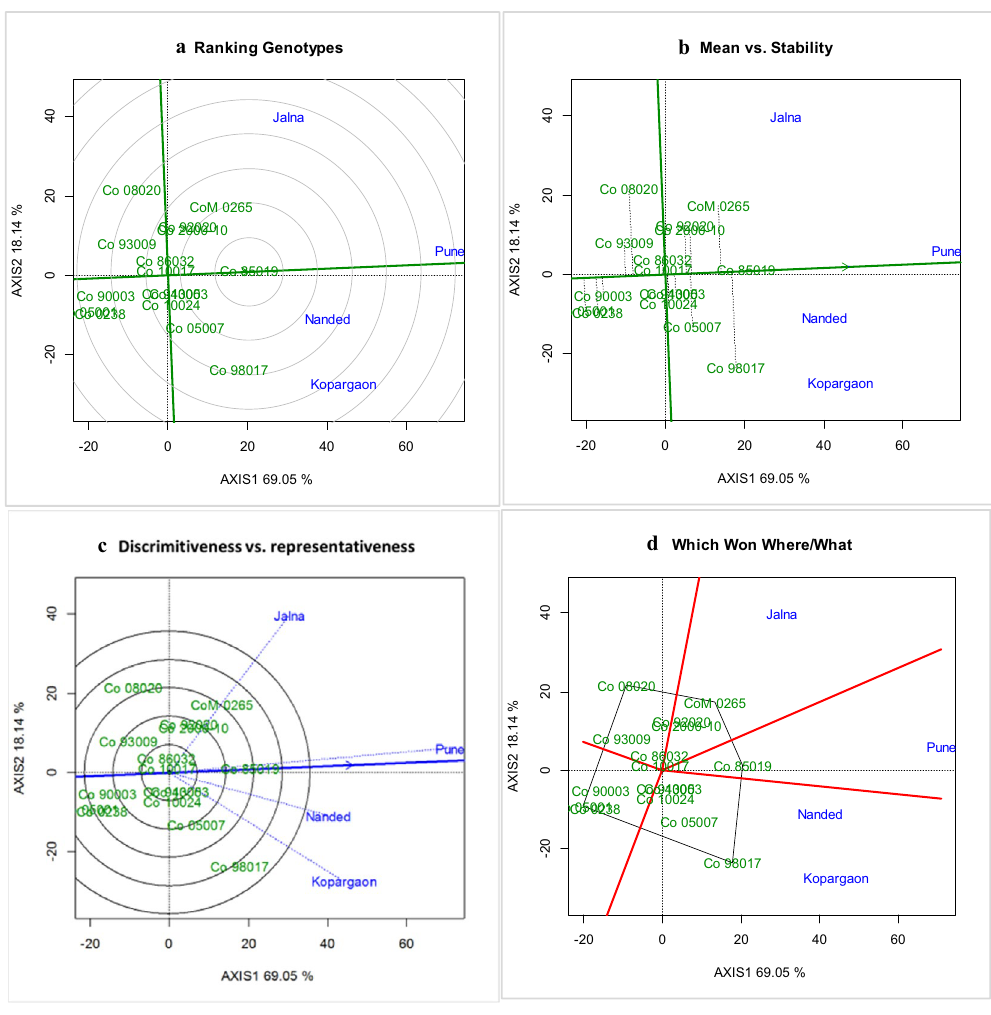
Figure 2. GGE Biplots of for cane yield (t/ha) under tillering phase in drought stress. The data is not transformed, not scaled, environments were centered (Centering = 2) and the biplots based on singular value partition by column metric preserving. The Biplots explained 87.19 percent of G + GE. ( a ) Ranking of genotype GGE biplot depicting the Co 85019 located in first concentric circle as ideal genotype for cane yield (t/ha), ( b ) mean vs stability GGE biplot depicting the Co 85019 located in the direction of the average environmental coordinates as best performing genotype for cane yield (t/ha), ( c ) discriminativeness vs representativeness GGE biplot depicting the longest environment vector and nearer to average environmental coordinates and identified Pune as highly discriminative environment, and ( d ) Which won where/what GGE biplot to visualise the mega environment and environment specific